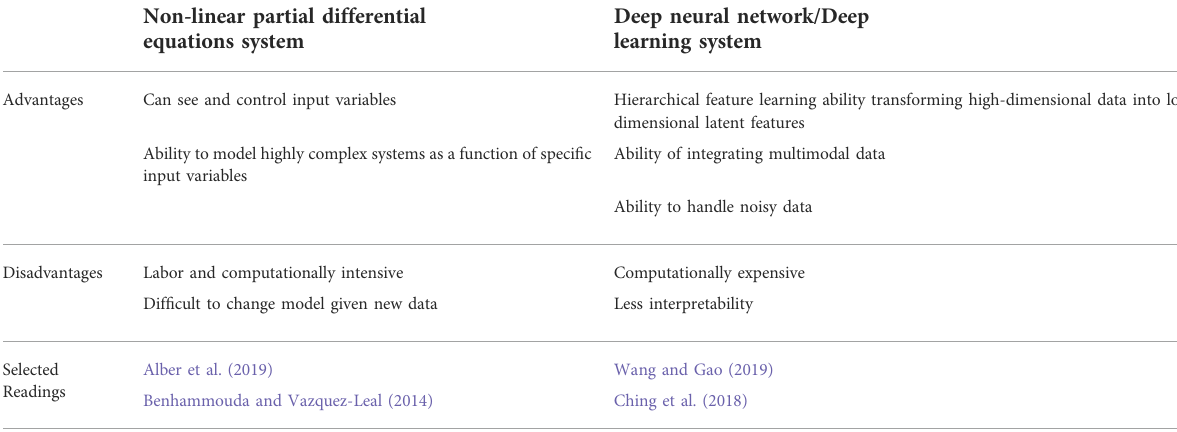
TABLE 1 Advantages and disadvantages of partial differential equation systems and deep learning